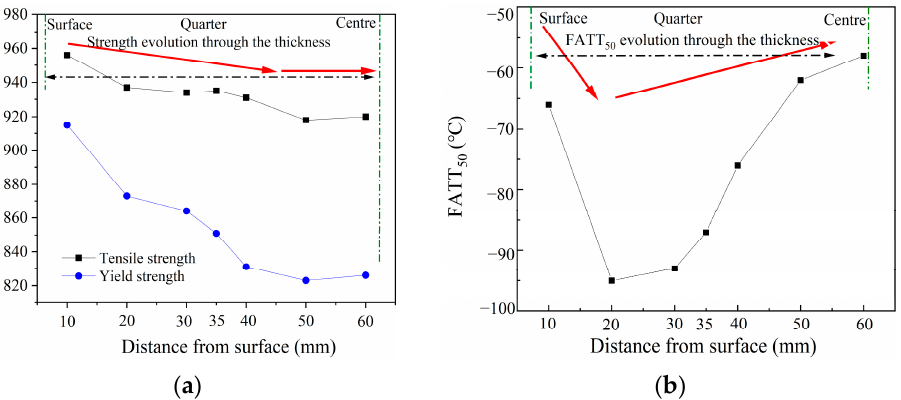
Figure 7. Mechanical properties of heavy plate: ( a ) strength evolution through the thickness and ( b ) evolution of FATT 50 shows a “V” shape.